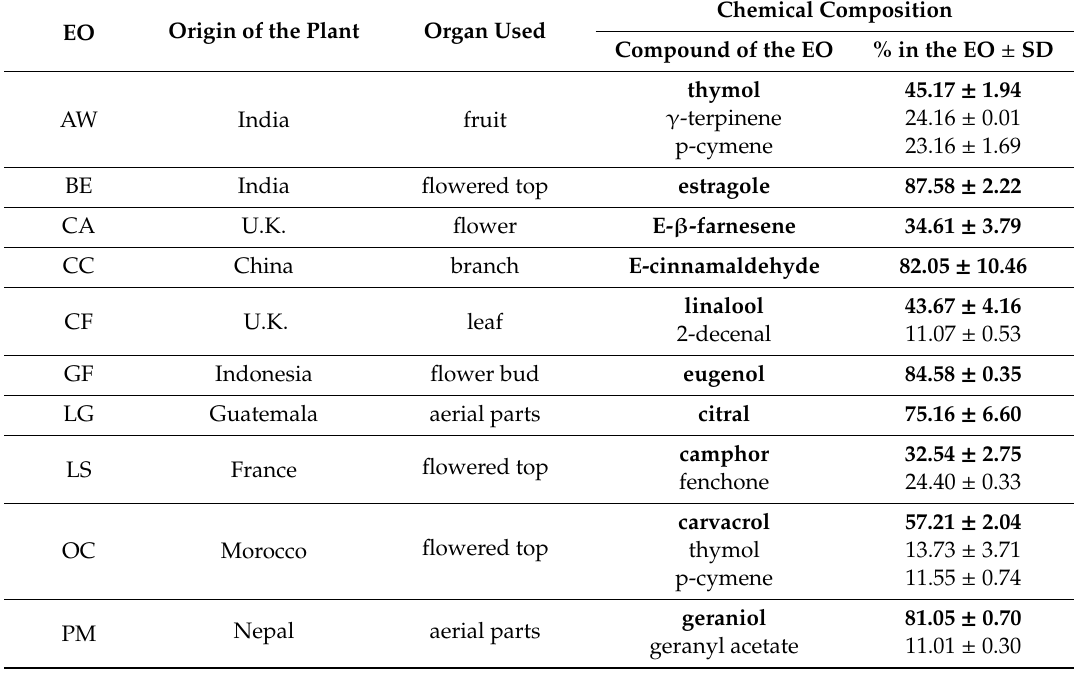
Table 7. Geographical origin, organ and chemical composition (compounds above 10%) ( n = 2) of the ten tested essential oils. In bold, the main